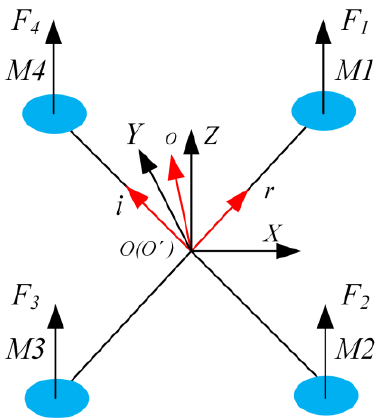
Figure 3. Analysis of quadrotor UAV dynamics.